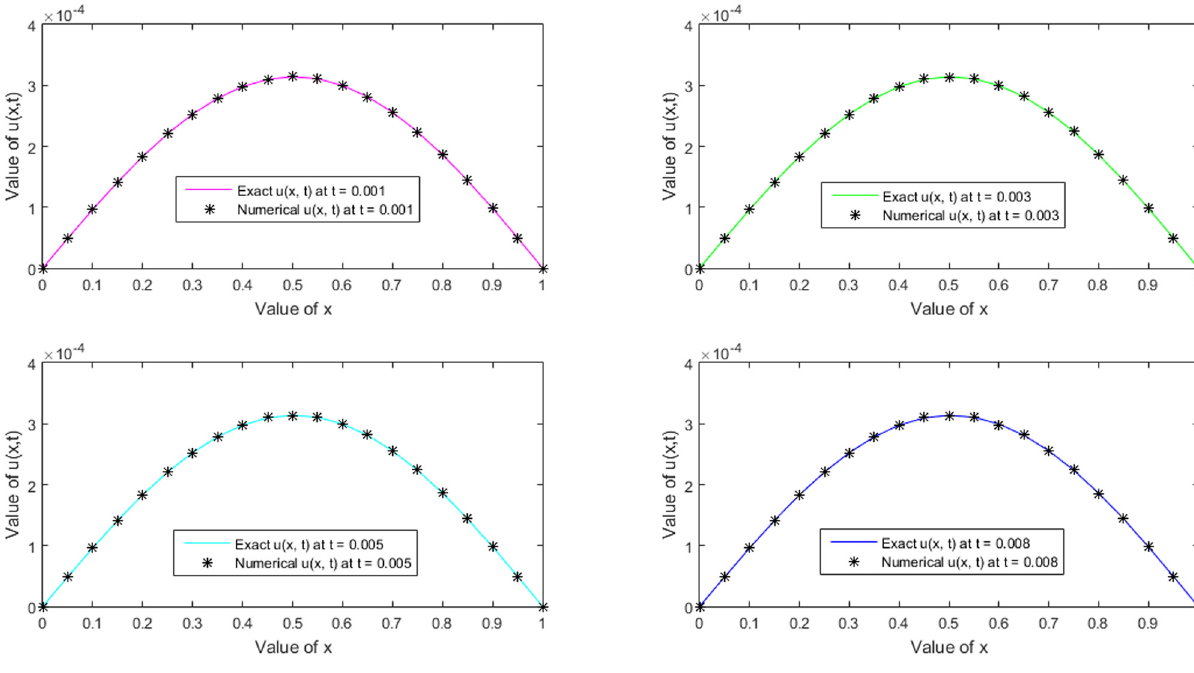
Figure 2: Solutions for = N 21 , = t Δ 0.0001 , = ν 0.005 , and = σ 100 .